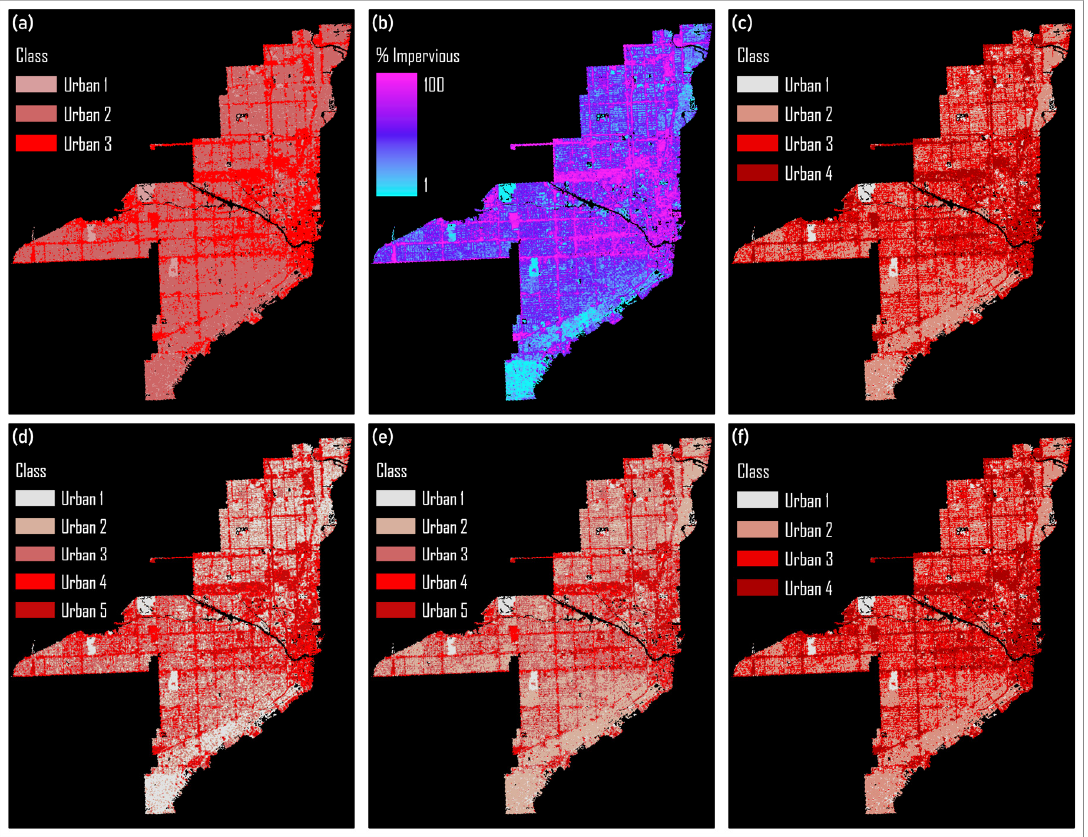
Figure 10. 2016 Miami urban land use classifications derived from Landsat 8 OLI data; ( a ) NDCCI/NBI/BAEI composite SVM, ( b ) NLCD 2016 Percent Developed Imperviousness, ( c ) fusion of NDCCI/NBI/BAEI SVM and Percent Developed Imperviousness, ( d ) NDCCI/NBI/BAEI composite iso cluster, ( e ) five-class fusion of Percent Developed Imperviousness with NDCCI/NBI/BAEI SVM and iso cluster, ( f ) four-class fusion of Percent Developed Imperviousness with NDCCI/NBI/BAEI SVM and iso cluster.